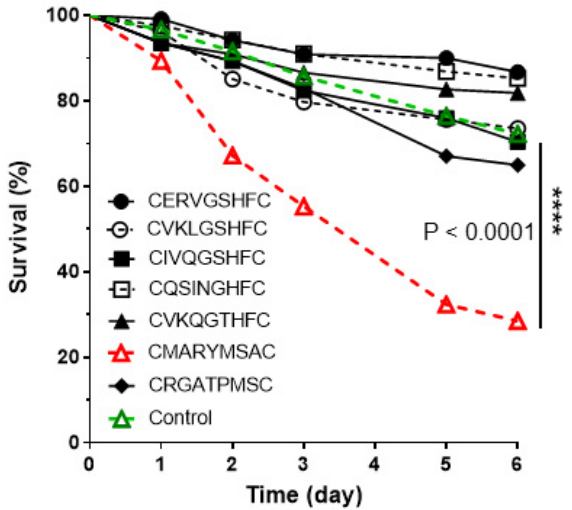
Figure 4. The survival curves of fire ant workers after being fed synthetic peptides. The control was 10% sucrose solution. Each treatment and the control consisted of 250 workers ants. The peptide, CMARYMSAC, showed ~26% survival after 5 days, and indicates significant differences by a standard Log-rank test. The other peptides showed survival rates that were not different from the saline control. After six days, there was no further ant mortality (****: p < 0.0001).